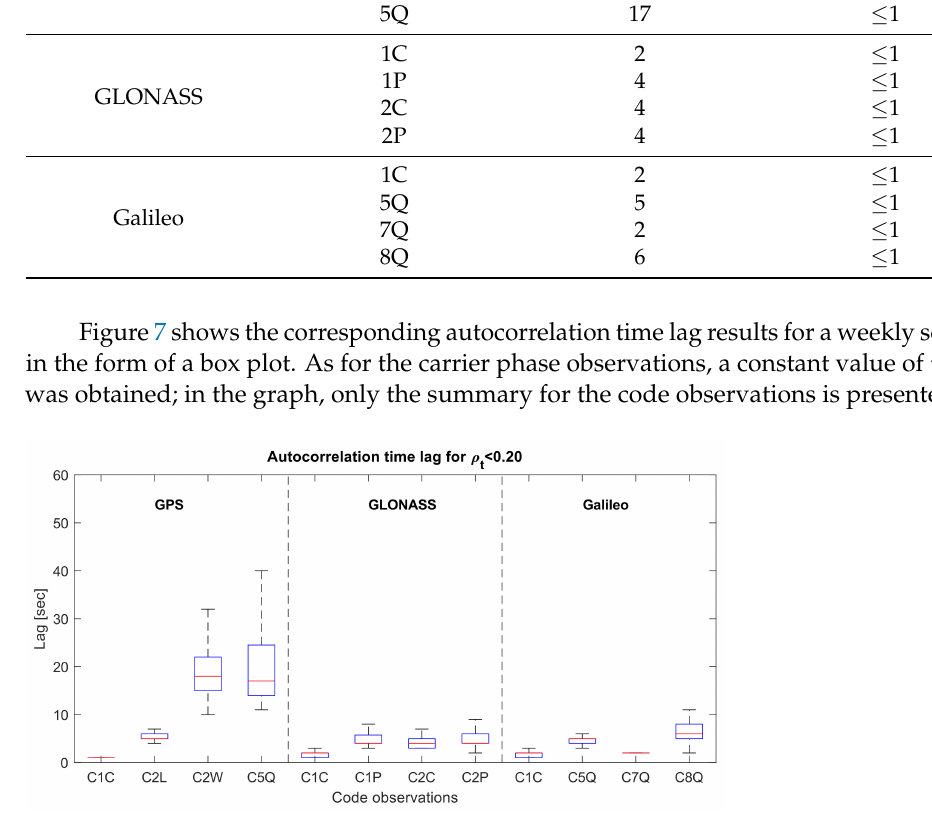
Figure 7. Autocorrelation time lag for code observations (weekly